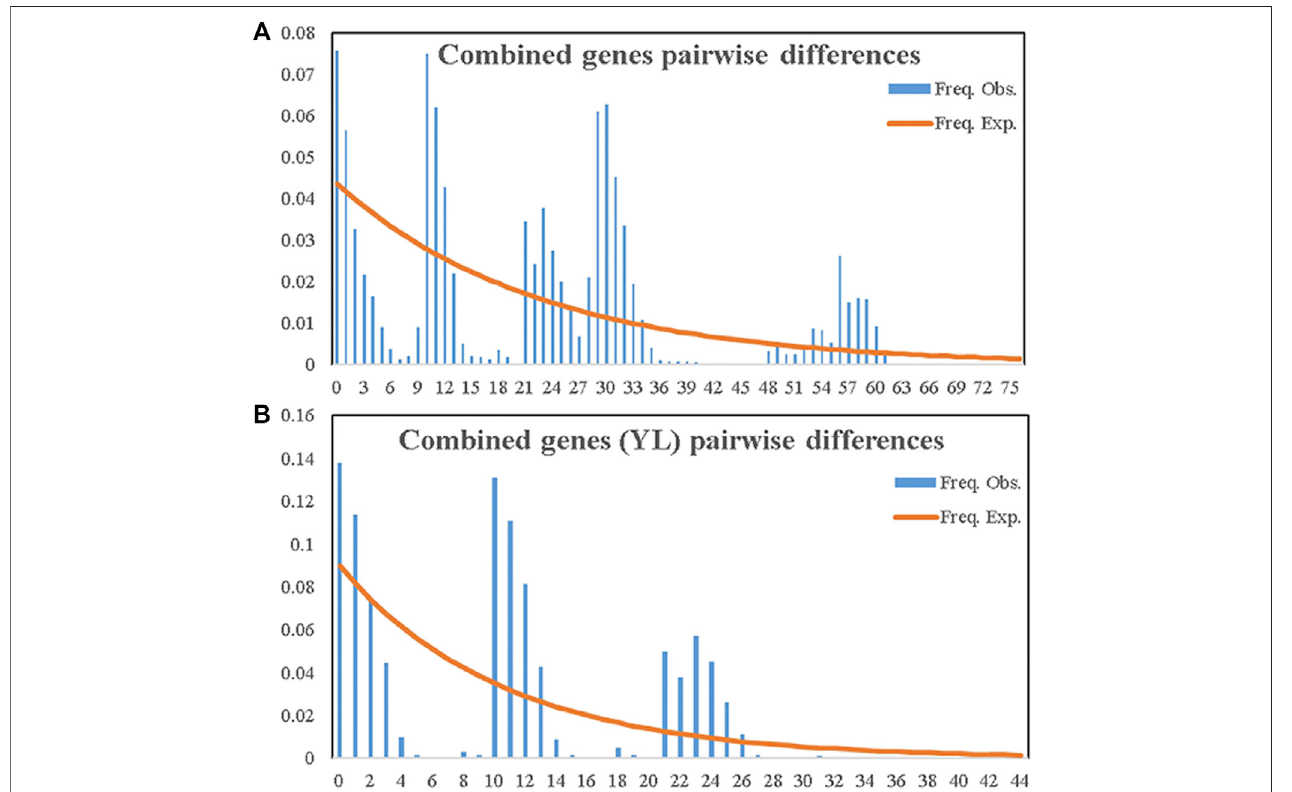
FIGURE 5 | Observed and expected mismatch distribution analyses of entire samples of A. mali in China (A) and the YL group (B) based on combined genes.